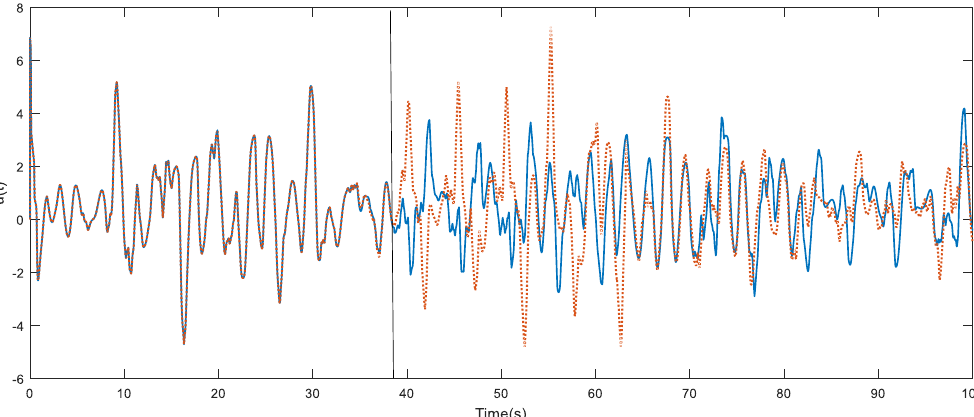
Figure 9. Controller signals based on the proposed robust adaptive control strategy (11) where it is activated at t = 5 s. The solid line is the control signal based on the fixed unknown time delays 𝜏 1 = 0.45, τ 2 = 0.1 and the dotted line isthe control signalbased on step-change of unknown variable time delays 𝜏 1 = 0.45 to 𝜏 1 = 0.5 at 𝑡 = 38.45 s and 𝜏 2 = 0.1 to 𝜏 2 = 0.7 at 𝑡 = 38.45 s .